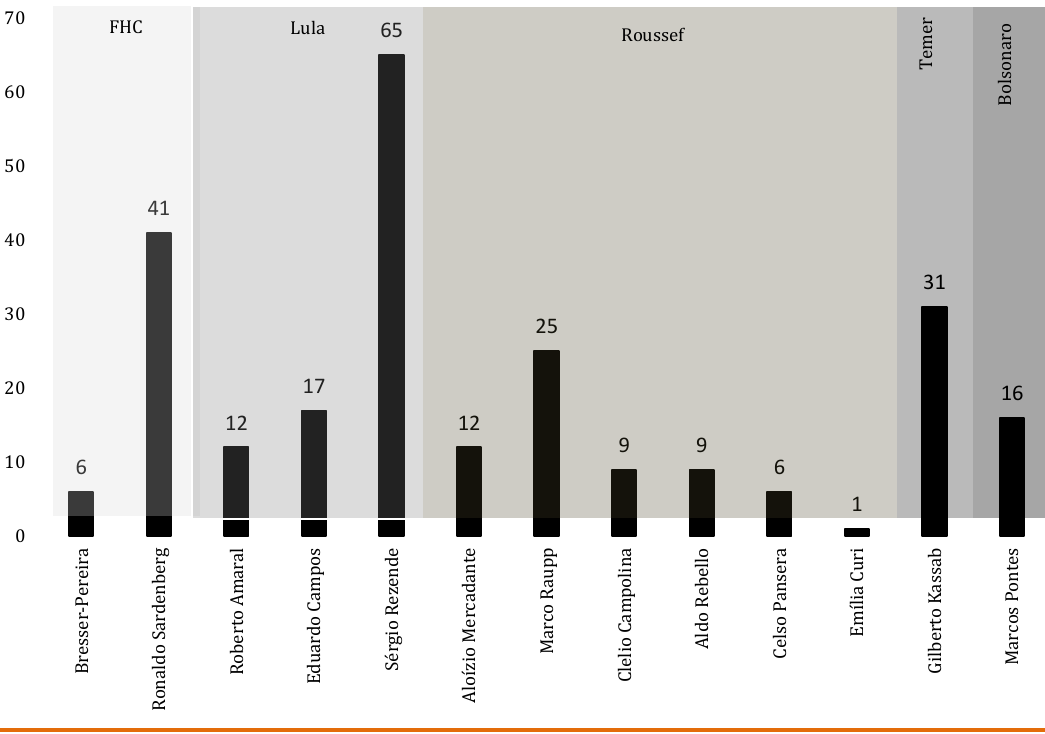
Source: Authors ’ own, based on Pelaez et al.